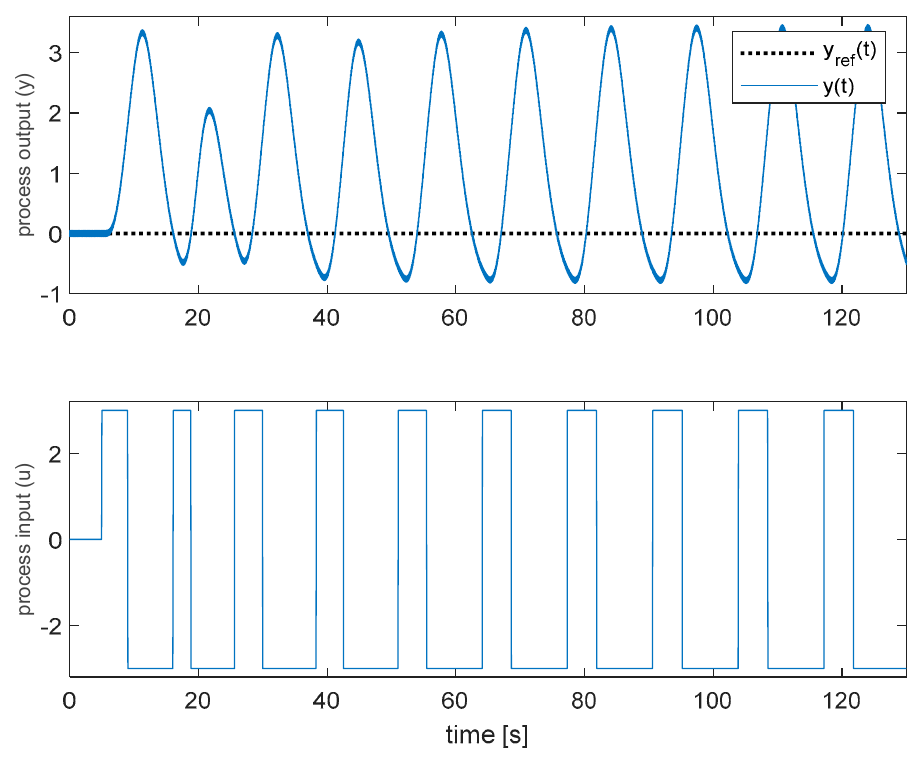
Figure 12. Response of the relay feedback method [1] combined with the time delay [7] for the high-order plus time-delay process with θ = 0.1 and PA set = − 3 π/4 .